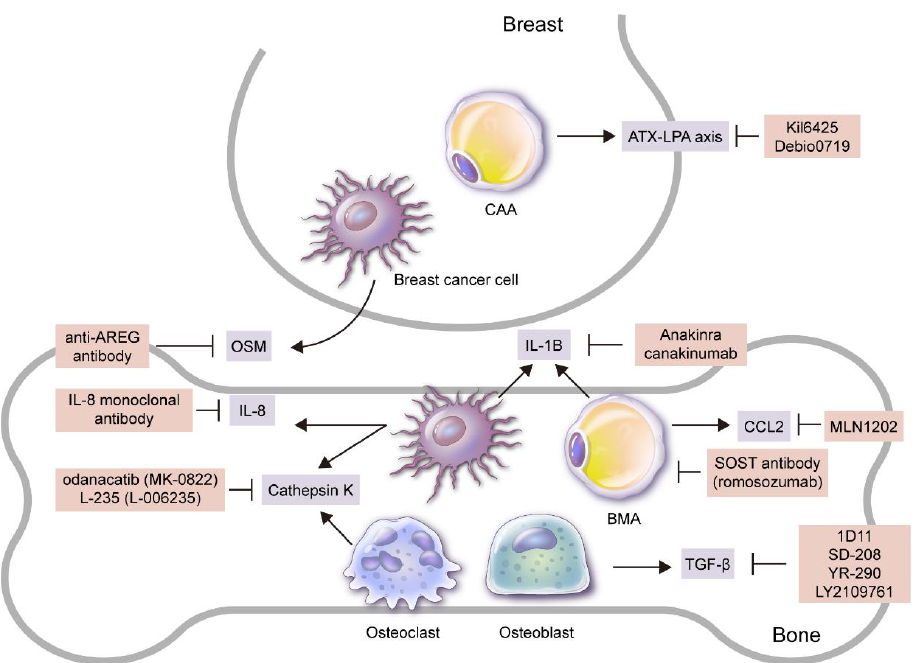
Figure 2. Candidates for targeted treatment of breast cancer bone metastasis through inhibition of adipokines and adipocytes. Adipokine and/or adipocyte inhibitors that have been reported to be effective in breast cancer bone metastasis treatment in preclinical and/or clinical studies are as follows: